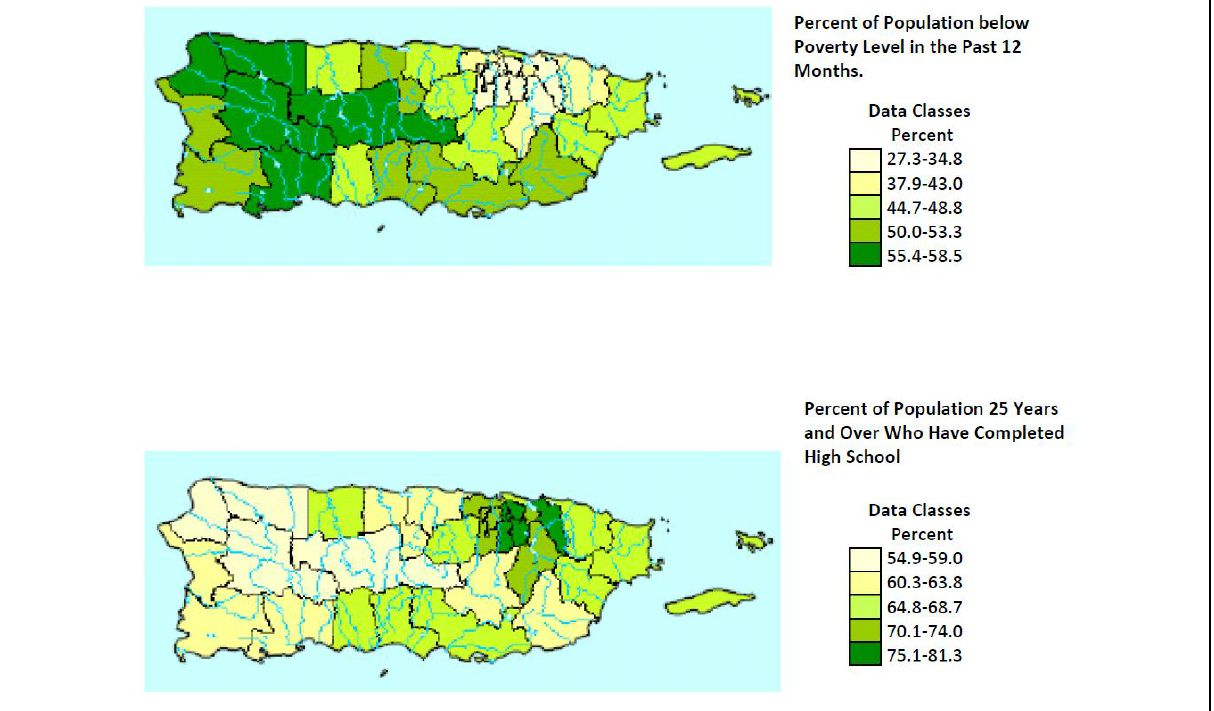
Figure 2. Geographic distribution of poverty and education in Puerto Rico. Data set: 2005-2009 Puerto Rico Community Survey 5-year estimates (public-use